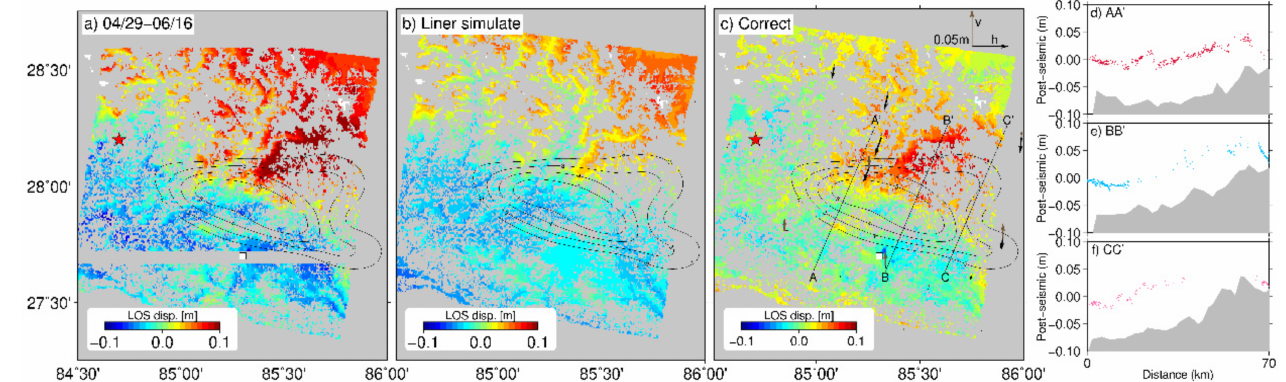
Figure 4. ( a ) Stacking phase of four interferograms of Sentinel data with the turbulent atmosphere removed; ( b ) simulated topographic phase; ( c ) the post-seismic deformation after correction; ( d – f ) profiles of the post-seismic deformation, shaded areas represent the